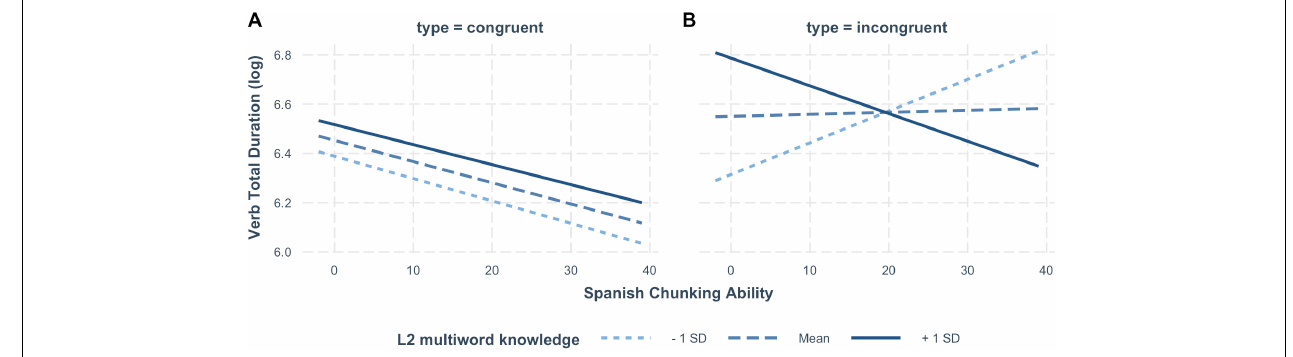
FIGURE 3 | Illustration of the effect of three-way interaction between on (A) congruent and (B) incongruent multiword units. L2 multiword knowledge serves as the critical L2 proficiency measure.